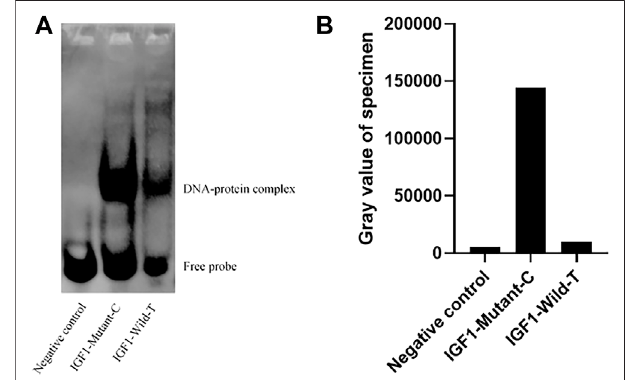
FIGURE 2 | Effect of mutations on the promoter activity of IGF1. IGF1- Mutant-C represents the mutant type, IGF1-Wild-T represents the wild type, and PGL3-basic represents control. They were transfected into 293T cells. The results are expressed as the mean ± SEM ( n = 3) in arbitrary units based on fi re fl y luciferase activity normalized against Renilla luciferase activity. A t-test was conducted using SPSS 25.0 to detect the differences. Bars represent the mean ± SEM of at least three repeats. * p < 0.05; ** p < 0.01.